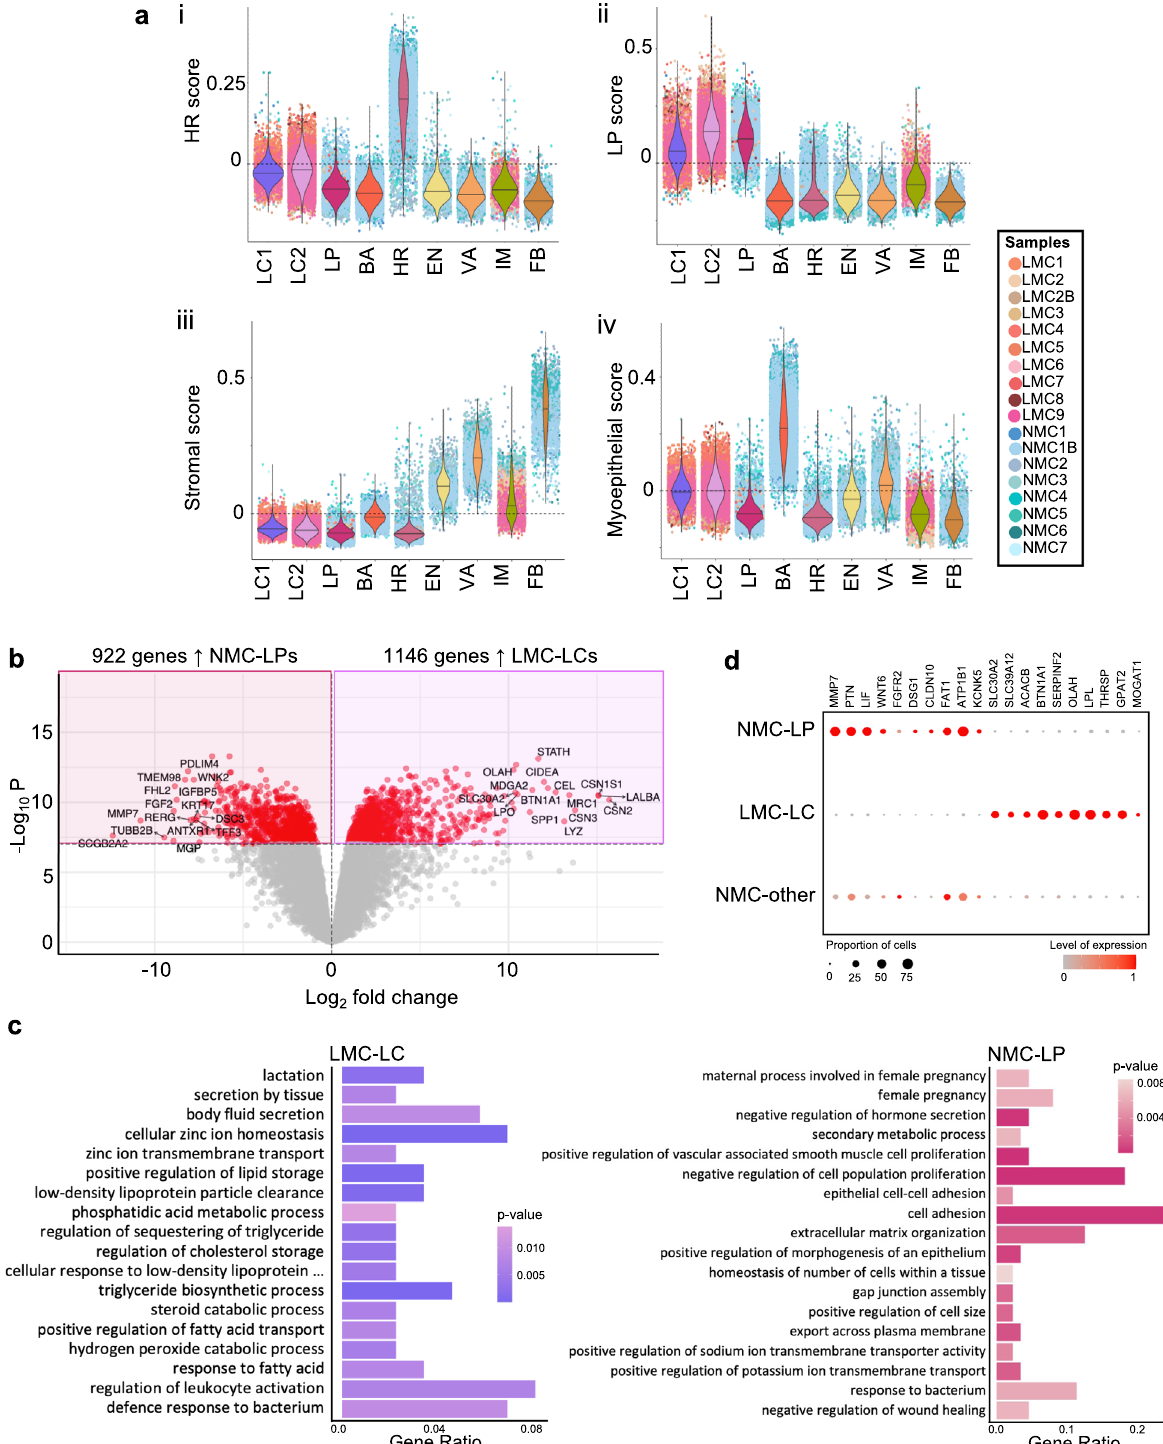
Fig. 4 Comparing lactation-derived mammary cell (LMC) luminal clusters (LCs) with all other non-lactating mammary cell (NMC) types reveals similarity to non-lactating luminal progenitor (LP) cells. a Violin plots of the mammary cell scores for i hormone-responsive (HR, mature luminal), ii luminal progenitor (LP), iii stromal or iv myoepithelial cells across the major cell clusters identi fi ed in this study. b Differential gene expression analysis derived using quasi-likelihood negative binomial generalized log-linear models revealed 1146 genes highly expressed in LC LMCs compared to 922 genes more highly expressed in LP NMCs, as displayed by a volcano plot (for a full list, see Supplementary Dataset 7). c Important biological process gene ontology pathways that were annotated by the top 10% of genes signi fi cantly differentially expressed (false discovery rate corrected p value <1 × 10 − 8 ) and upregulated in either LC (left) or LP (right); for a full list, see Supplementary Dataset 8 and 9. d Key LP (left) or LC (right) genes expressed in NMC-LP, LMC-LC or all other NMC clusters; colours represent overall normalized gene expression and size equals cell